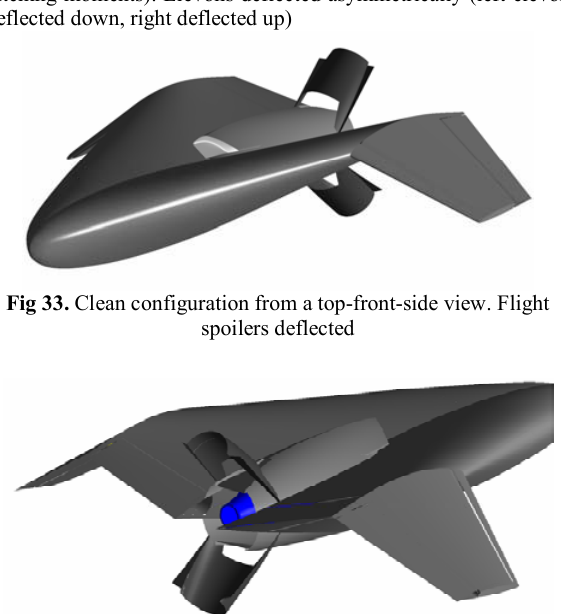
Fig 32. Flap-tabs (at the trailing edge of the blended-wing body) deflected up (it is typical in horizontal flight for equilibrium of